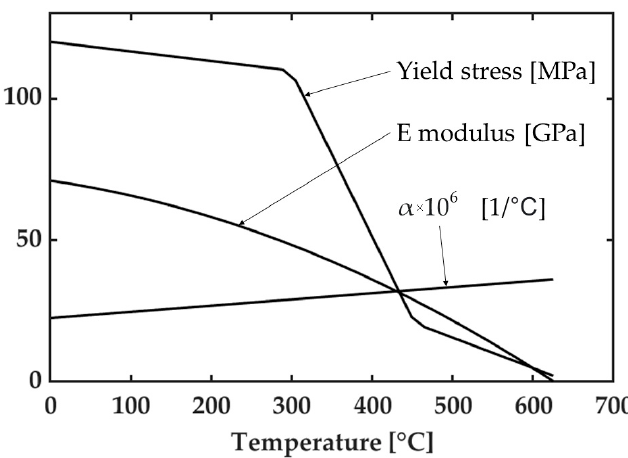
Figure 3. Material properties of AA6082 aluminum alloy.